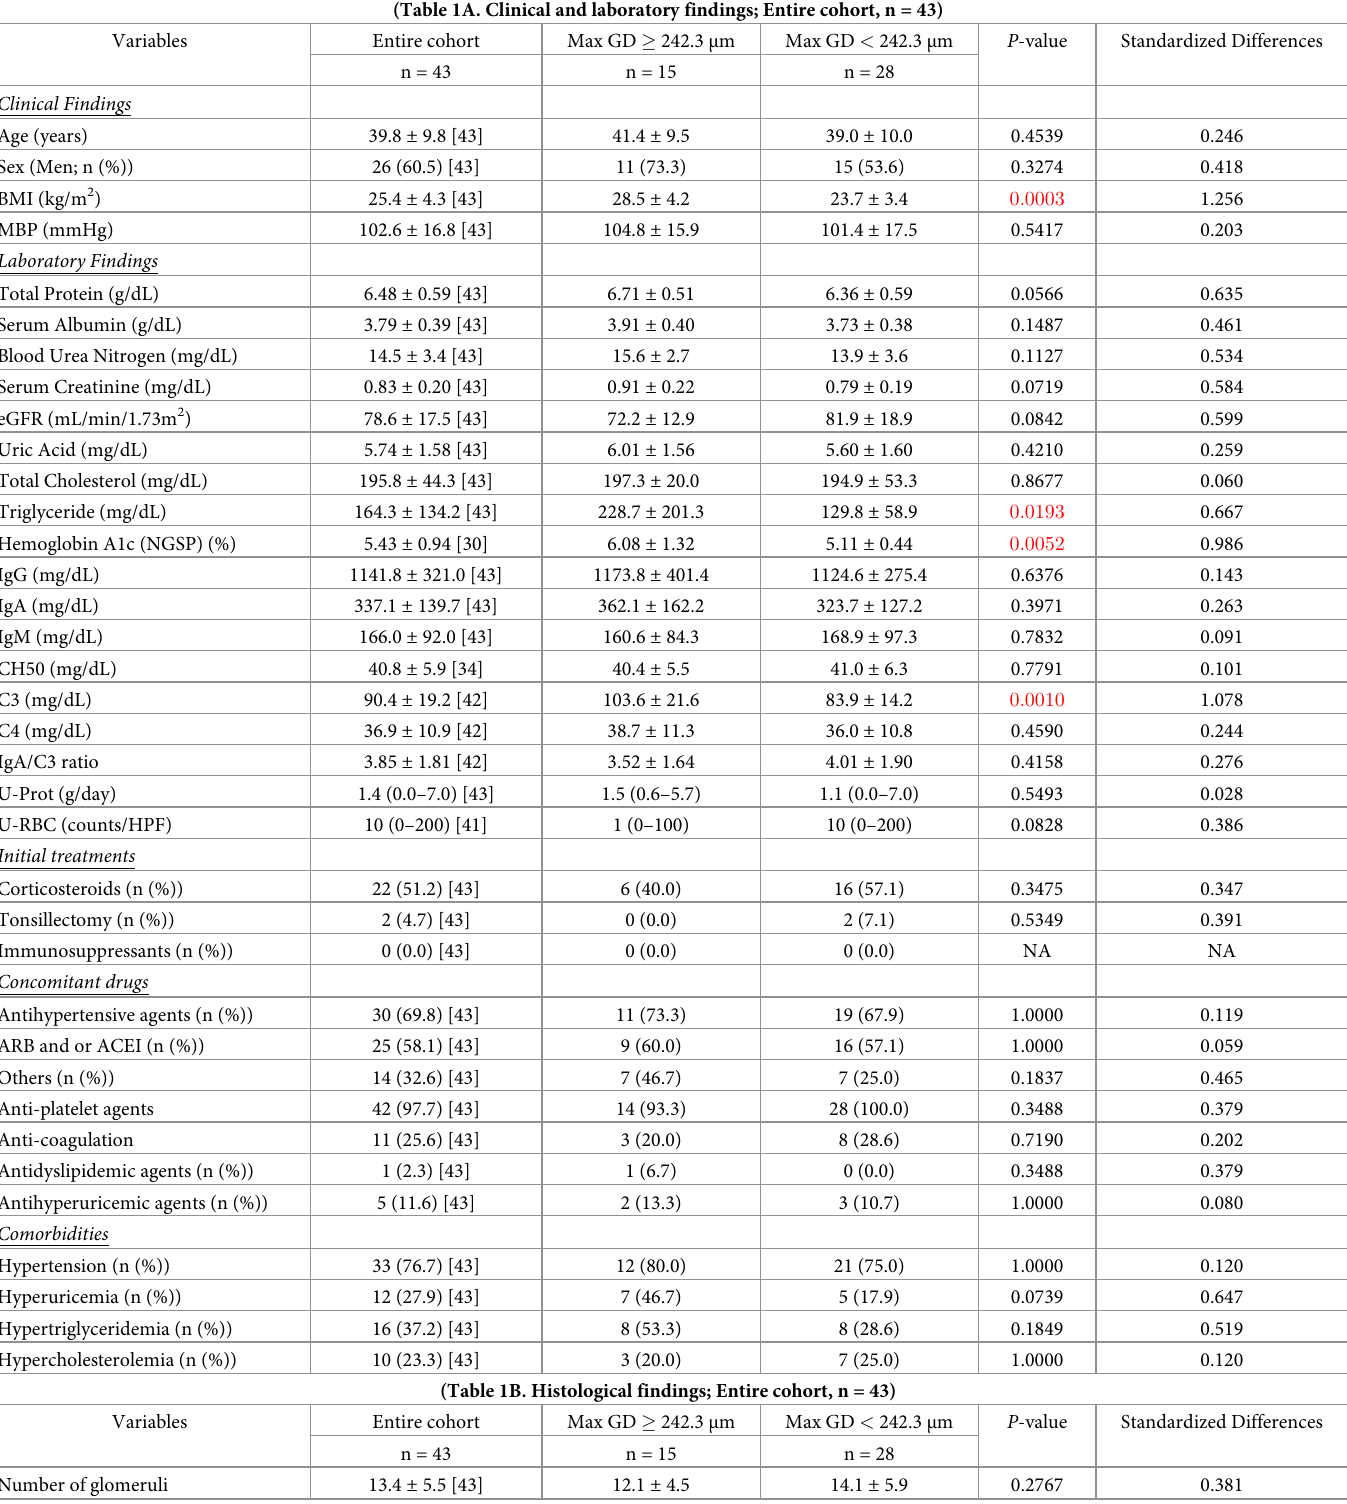
Table 1. Patient characteristics according to baseline Max GD levels. (Table 1A. Clinical and laboratory findings; Entire cohort, n = 43)